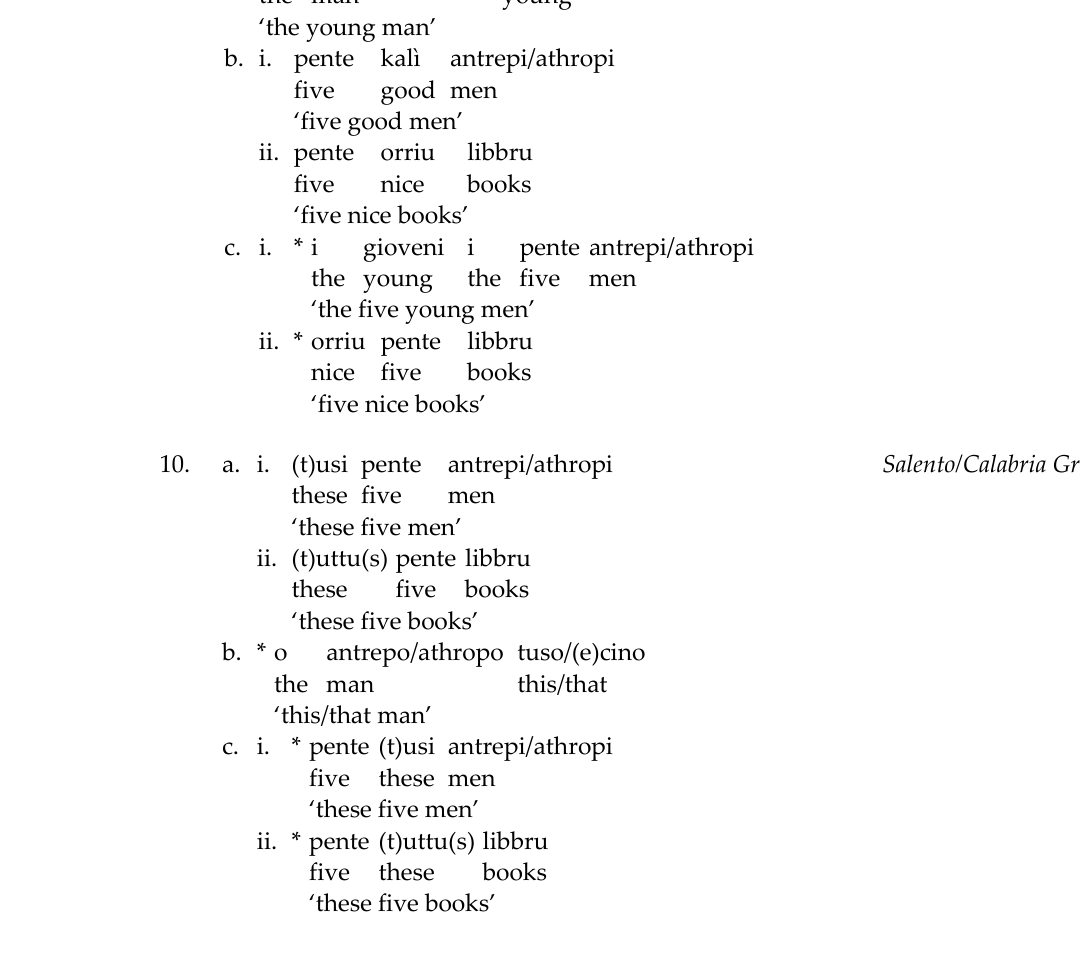
Table 2. X Num N Table 2. X Num N .